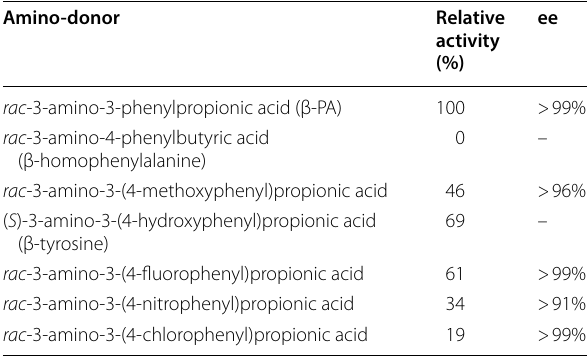
The reactions were carried out in 50 mM TRIS-buffer at pH 8, with an acceptor molecule concentration of 5 mM. The total protein-concentration of the cell lysate was set to 0.2 mg/mL. ee% was determined after 30 min of reaction